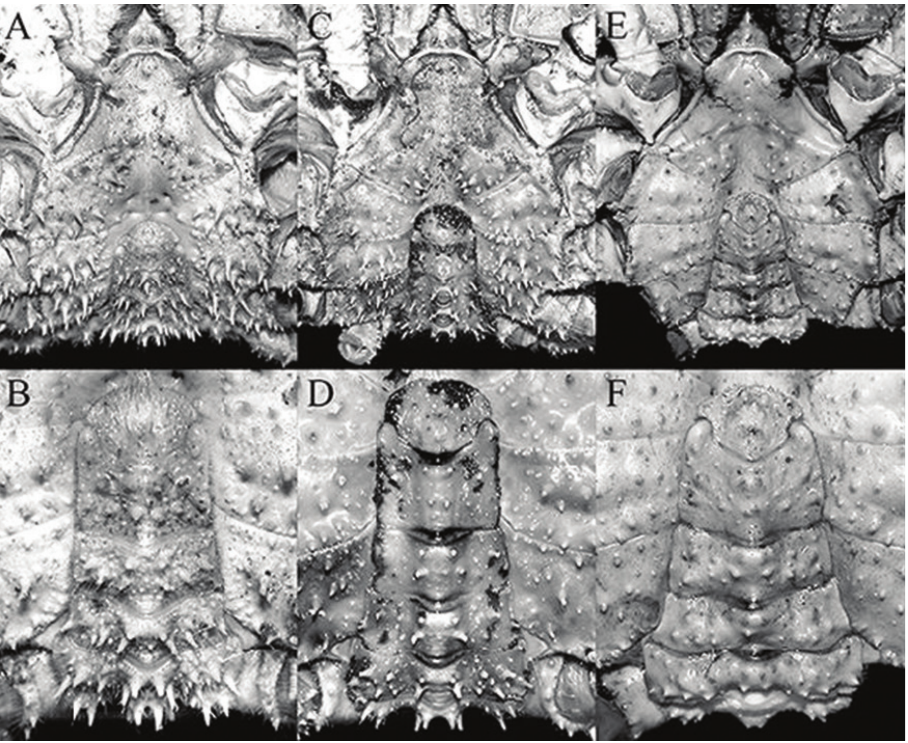
Figure 9. A, B Pleistacantha moseleyi (Miers, 1885), male (cl 82.5 mm, cw 61.6 mm) (ZRC 2005.117), Philippines C, D Pleistacantha pungens (Wood-Mason, in Wood-Mason & Alcock, 1891), male (cl 94.0 mm, cw 67.6 mm) (ZRC 2016.23), Myanmar E, F Pleistacantha kannu sp. n., holotype male (cl 106.2 mm, cw 87.0 mm) (CASAU), India. A, C, E anterior thoracic sternum and pleon; B, D, F male